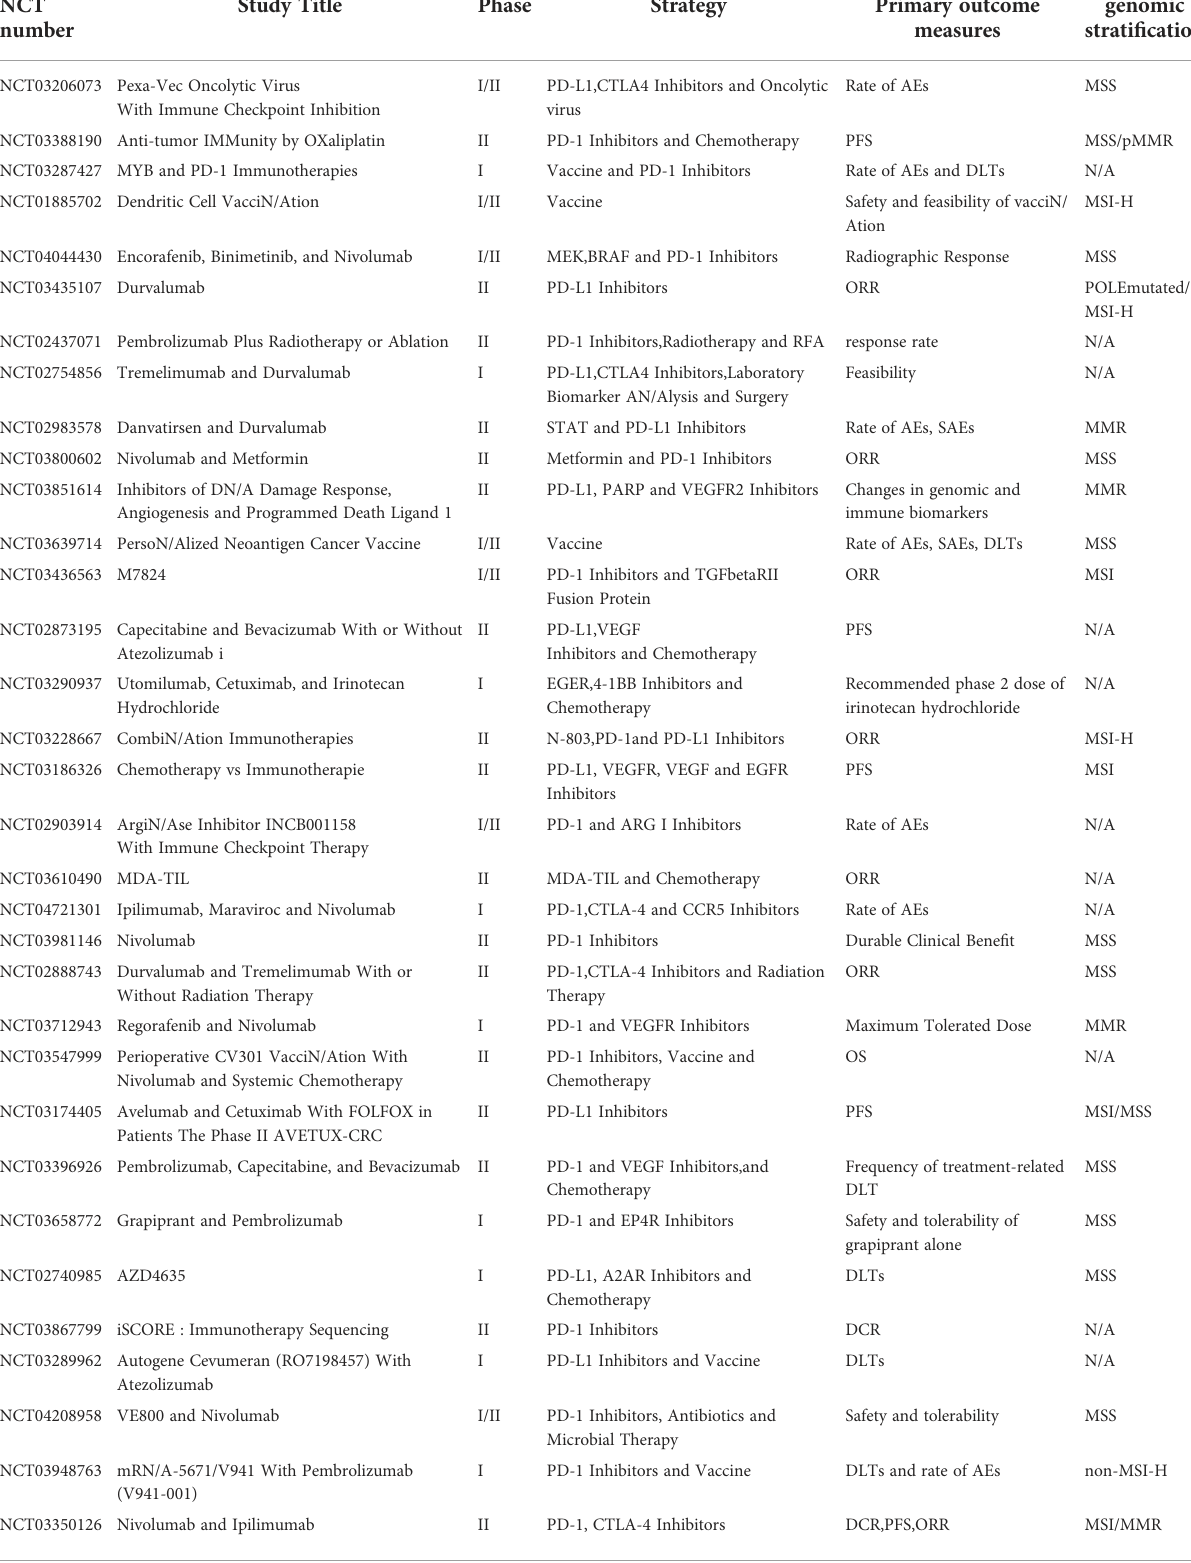
TABLE 1 Ongoing clinical trials of immunotherapy for CRC